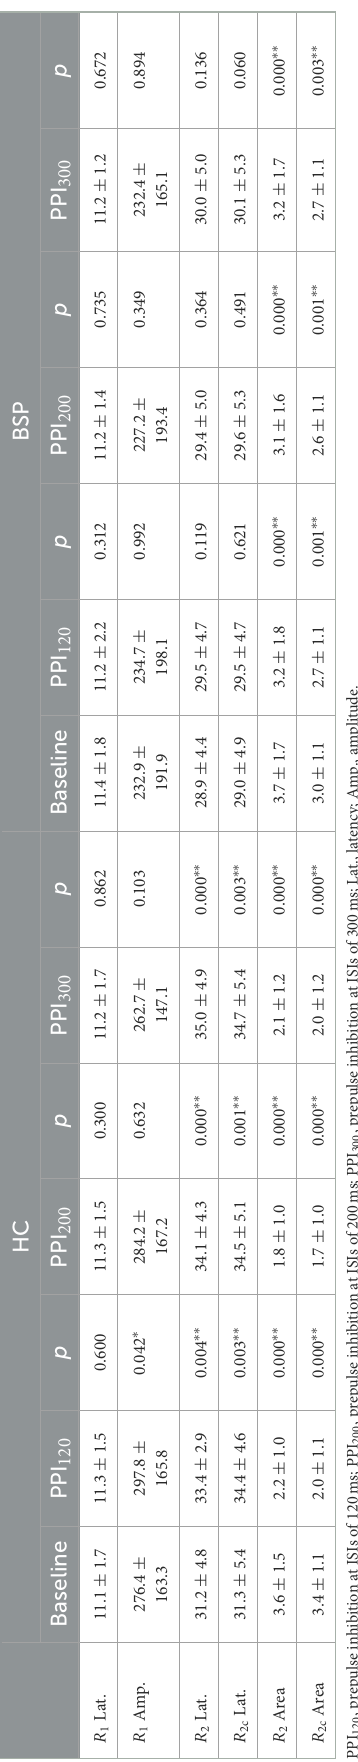
(Figures 1, 5). Finally, we found no correlations between PPI size and motor symptom severity or disease